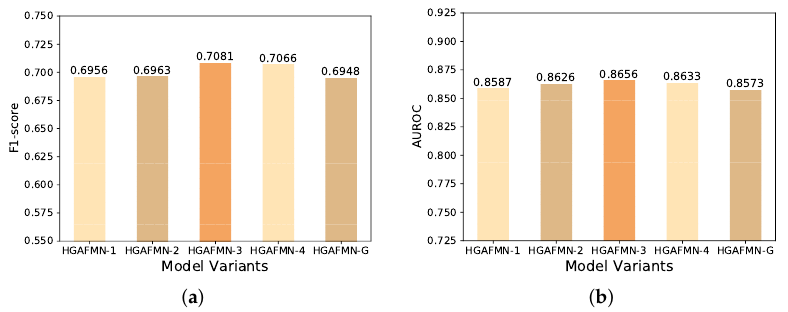
Figure 10. ( a ) Performance comparison with respect to layers of HGNNs on F1-score; ( b ) performance comparison with respect to layers of HGNNs on embedding size.